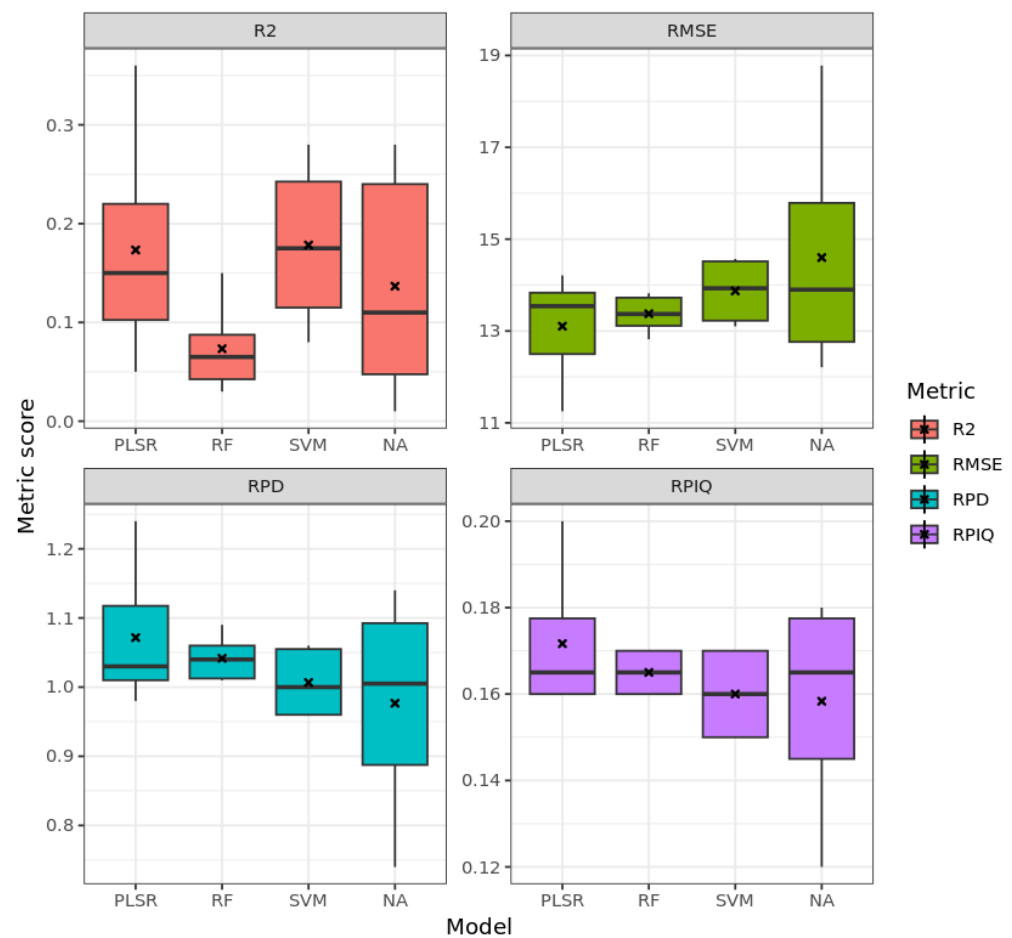
Figure 19. Box plots for the accuracy metrics for PRISMA estimations of CaCO 3 with the use of the PLSR, Cubist, RF and SVM algorithms for all preprocessing methods.